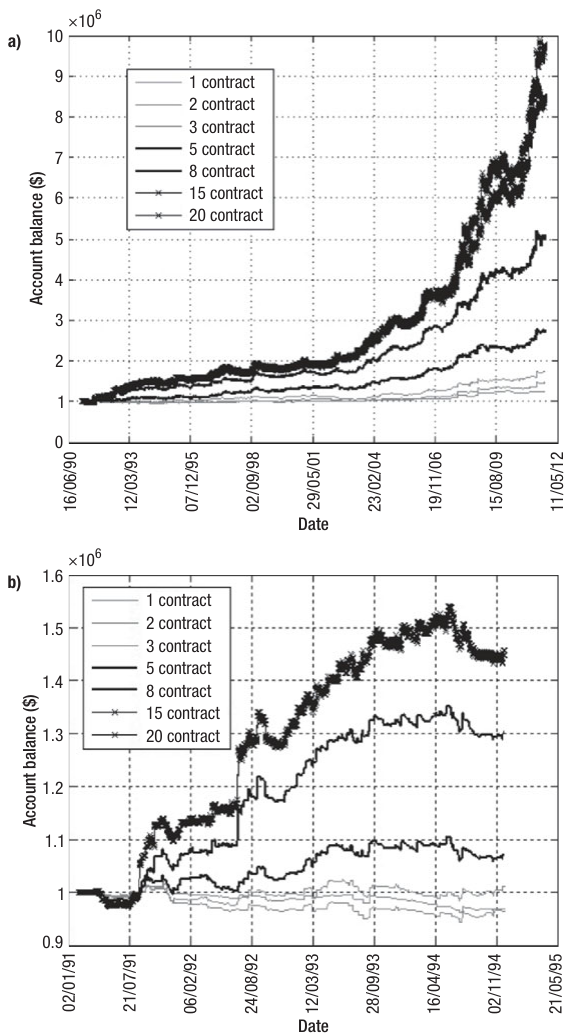
Fig. 6. Impact of portfolio diversi fi cation on the